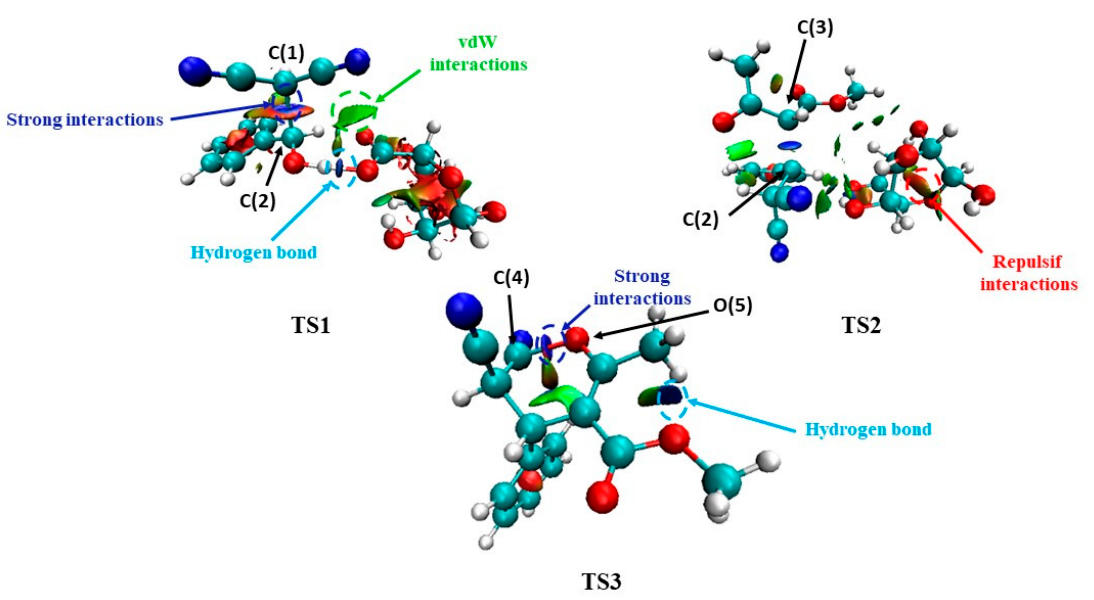
Figure 7. NCI analysis of TSs for the one-pot reaction for the synthesis of 4a catalyzed by SA (s = 0.3). For color codes: green (carbon atoms), red (oxygen atoms), blue (nitrogen atoms) and white (hydrogen atoms).